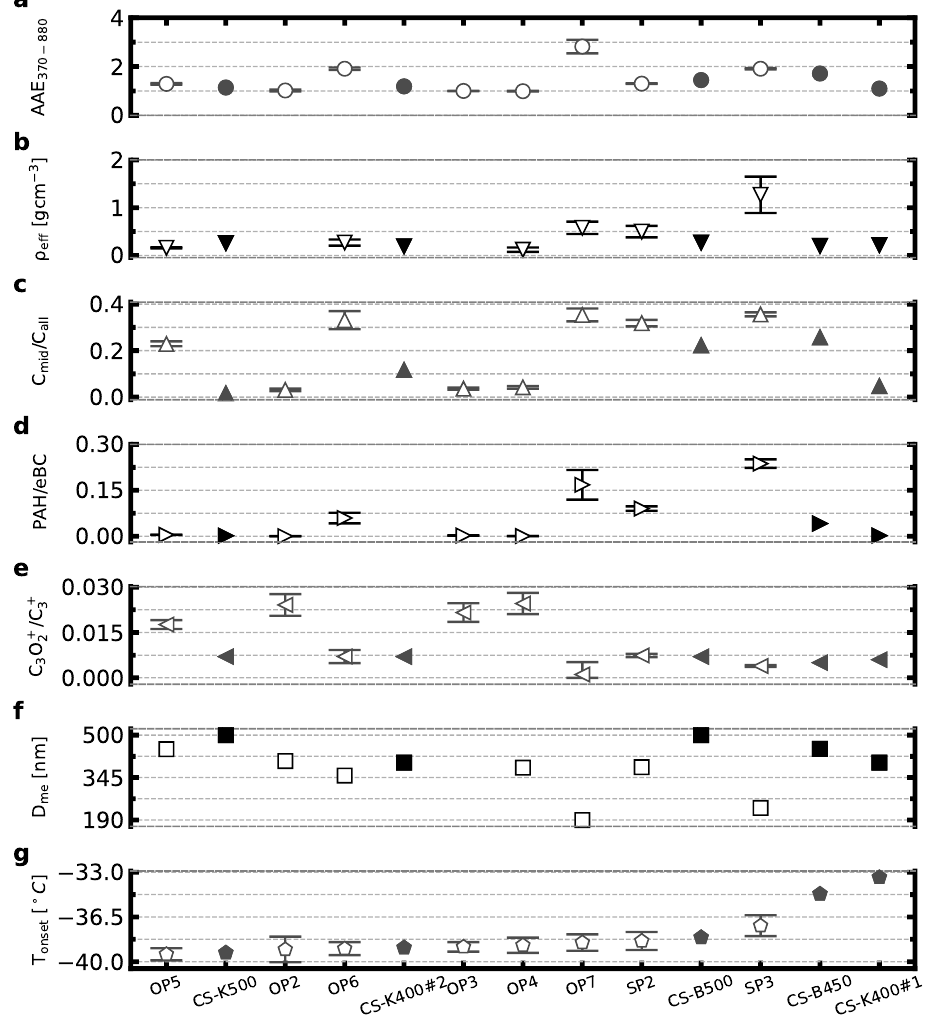
Figure 5. From top to bottom: ( a ) absorption Angstrom exponent for wavelengths 370 to 880 nm, ( b ) particle effective density, ( c ) SP-AMS midcarbon to all carbon signal ratio, ( d ) SP-AMS concentra- tion of particle phase polycyclic aromatic hydrocarbons normalised to aethalometer black carbon concentration, ( e ) SP-AMS C 3 O 2+ to C 3+ signal ratio, ( f ) mean mobility equivalent diameter, and ( g ) onset temperature AF ∗ = 10 − 3 derived from AF ∗ data (Figure 3b), for each miniCAST setpoint sample (presented as white markers in the figure). The sample setpoints on the x-axis are in order of increasing onset temperature. Results of Korhonen et al. [13] for immersion mode IN from forced draft gasifiers burning spruce/pine-mixture pellets are included (presented as black markers and prefixed with CS on the x -axis), with the exception of two experiments where AMS data did not allow for inferring PAH levels. Effective density is omitted for OP2 due to low APM data quality, and effective density and mobility diameter is omitted for OP3 due to SMPS size distribution data not being monodisperse over the measurement period. A correction factor of 2.8 was used for the eBC data from this study. Uncertainties presented are of one standard deviation from the variability in recorded data during sampling. A point represents 5–10 min of data